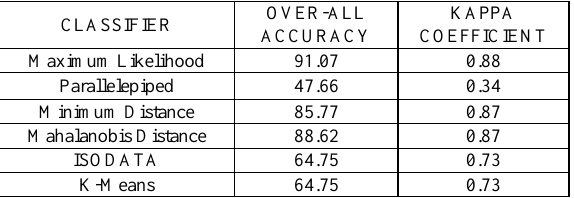
Table 1. Different classifiers used in the study and their overall accuracy and kappa coefficient values.